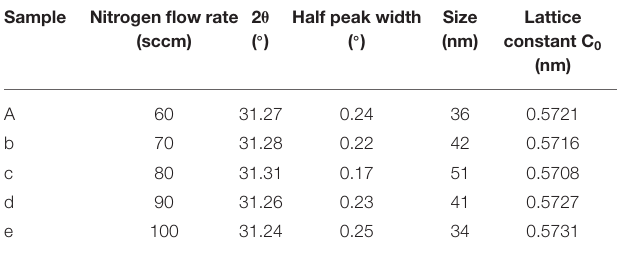
TABLE 1 | The InN (0002) diffraction peak position, FWHM, lattice parameter of c-axis, and grain size. Sample Nitrogen flow rate